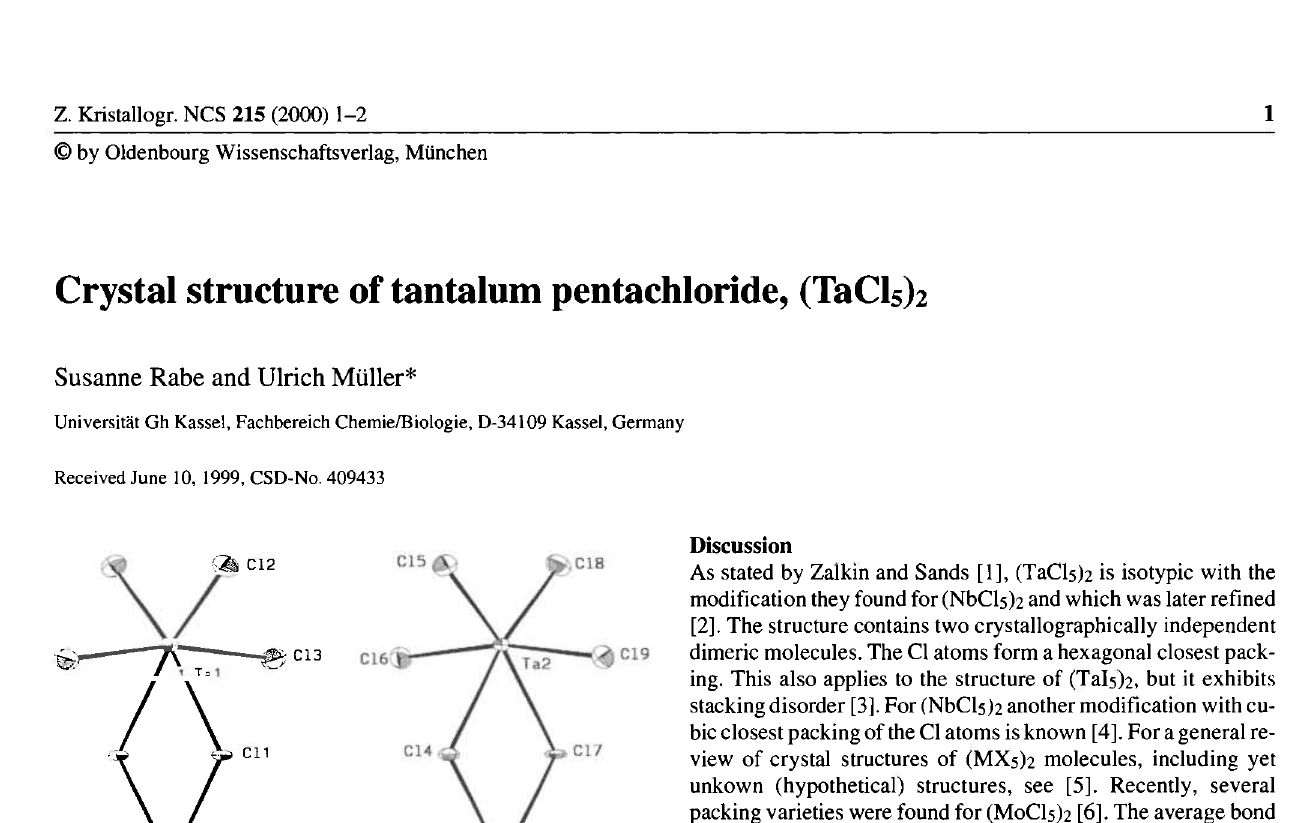
Table 1. Data collection and handling. Crystal: